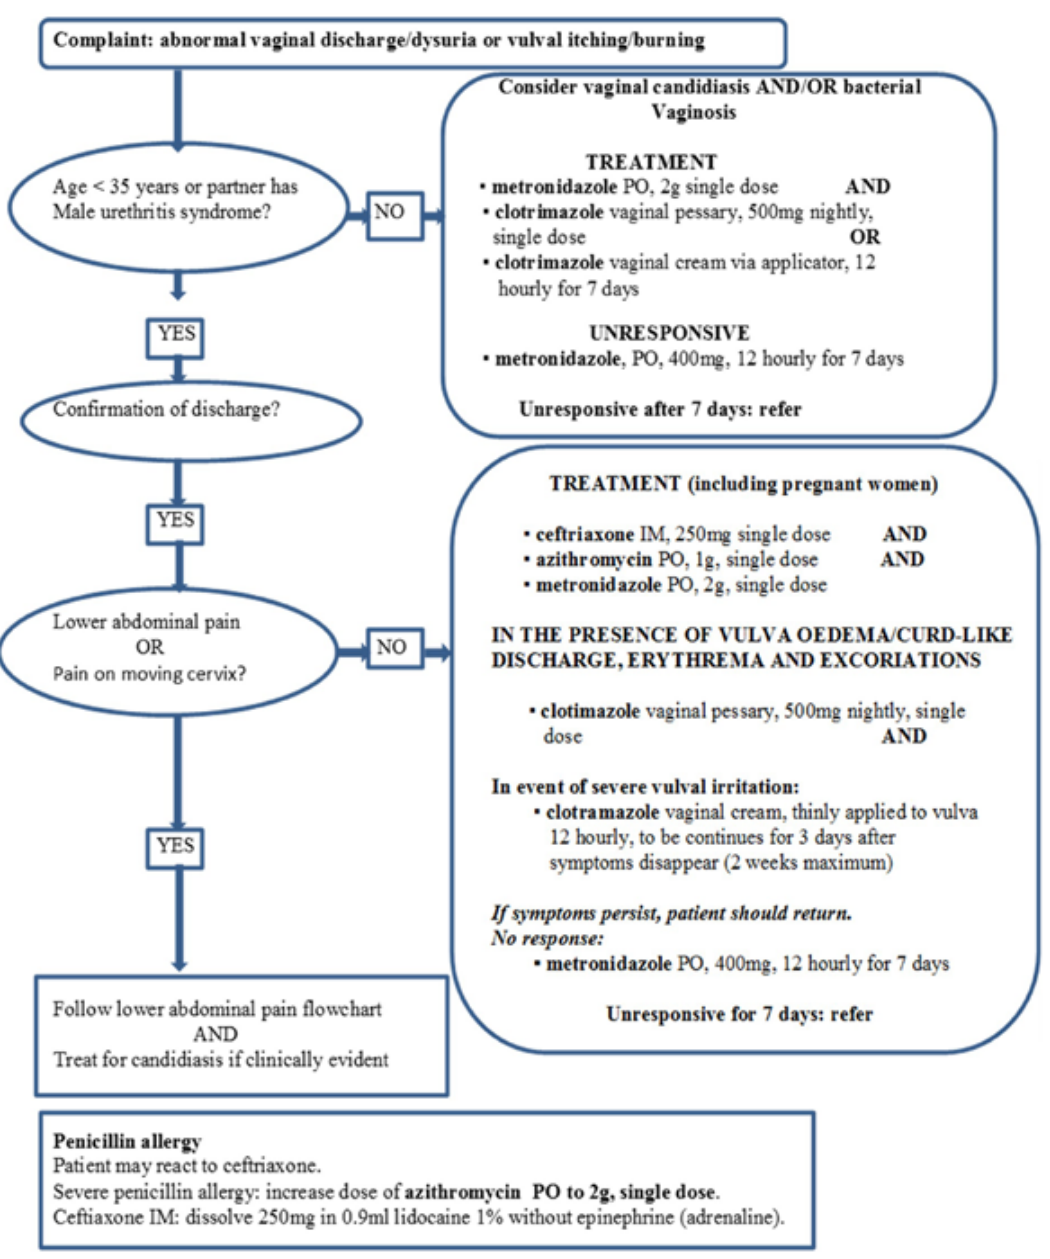
Figure 1: Flowchart of syndromic treatment of Vaginal Discharge Syndrome. (adapted from the revised VDS flowchart of the Primary Health Care Standard Treatment Guidelines and Essential Drugs List, 2015)